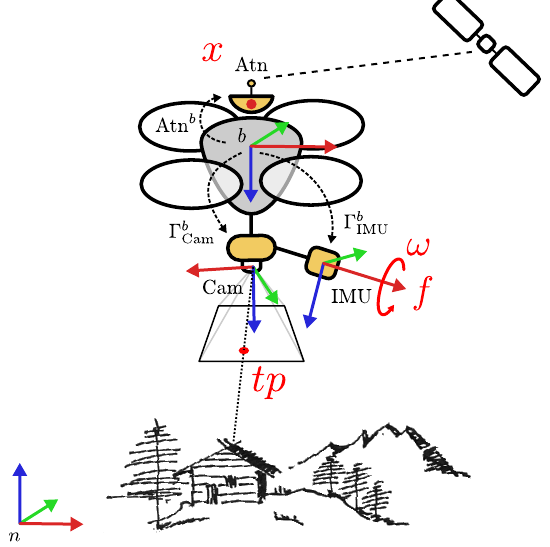
Figure 1. The reference frames considered in ODyN . The supported measurement types, GNSS position ( x ), IMU specific force ( f ) and angular velocity ( ω ) and image measurements ( tp ) are highlighted in